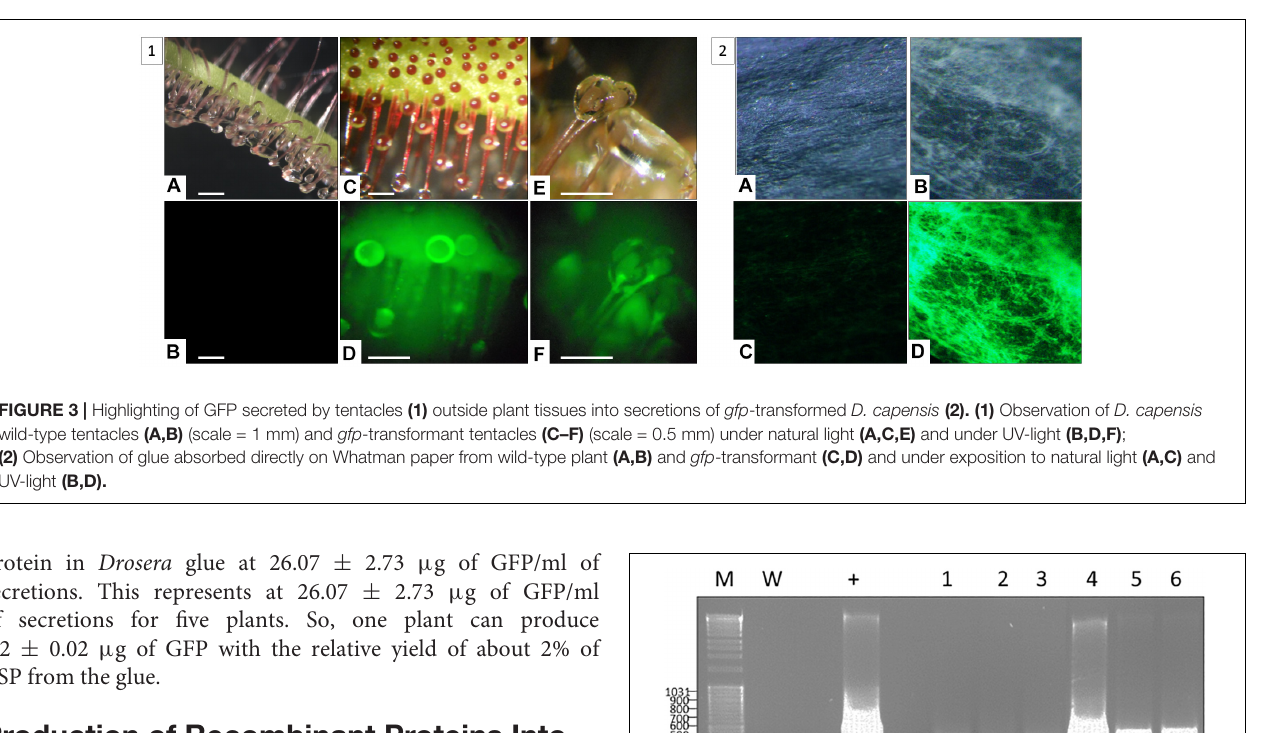
protein in Drosera glue at 26.07 ± 2.73 µ g of GFP/ml of secretions. This represents at 26.07 ± 2.73 µ g of GFP/ml of secretions for five plants. So, one plant can produce 0.2 ± 0.02 µ g of GFP with the relative yield of about 2% of TSP from the glue.